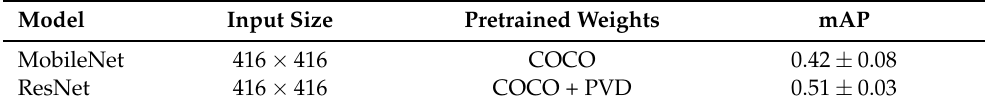
Table 2. Results on other datasets via a backbone based on position attention block. Model